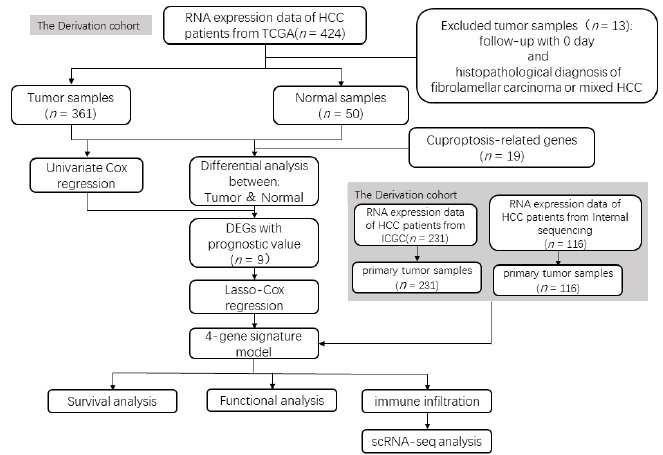
Figure 1. Flow chart of patients’ enrollment and data processing. ‘ n ’ means the number of samples or genes.